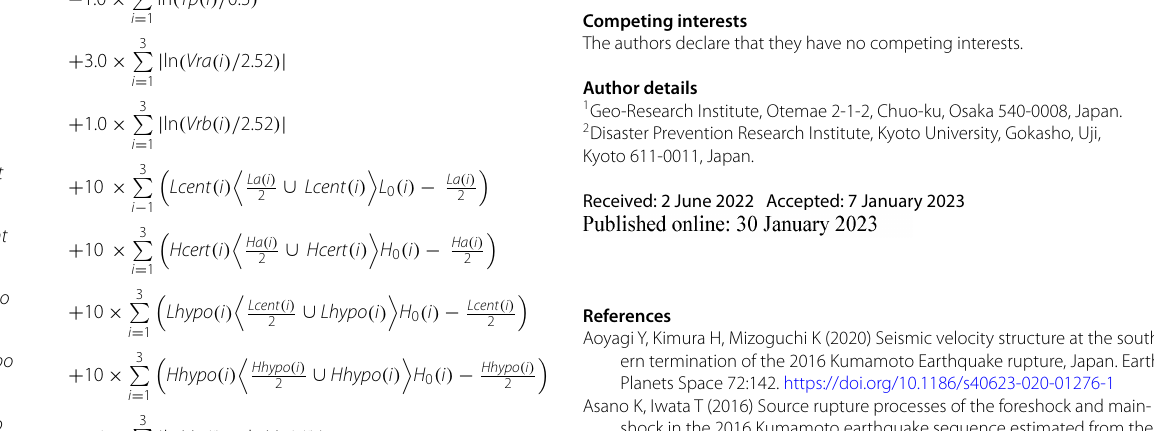
Table 7 Set of the penalty constraints for the SS search Param Penalties for the WM value